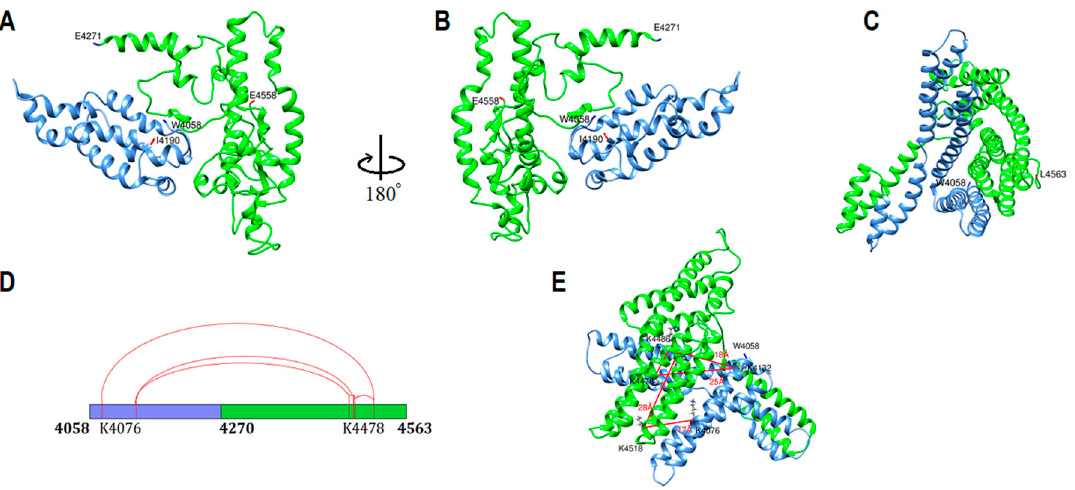
HHpred for homology detection. The first two templates were selected for subunit V domain 1 and the last five templates for subunit V domain 2 modeling.